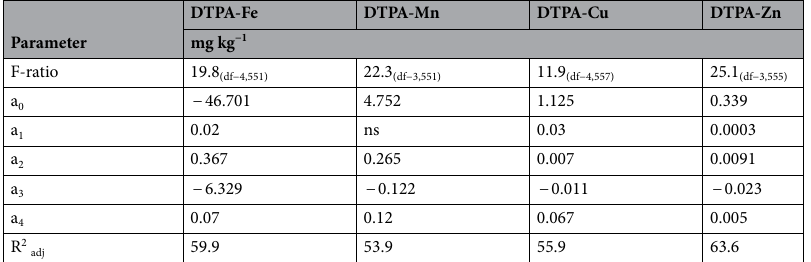
Table 5. Parameters of multiple regression of DTPA extractable micronutrient contents—Fe (Y1), Mn (Y2), Cu (Y3) and Zn (Y4) of elevation and soil variate of NE soils: clay, pH, SOC (Y1 = a0 + a1 × elevation + a2 × clay + a3 × pH + a4 x SOC); (Y2 = a0 + a2 × clay + a3 × pH + a4 × SOC); (Y3 and Y4 = a0 + a1 × elevation + a2 × clay + a3 × pH + a4 × SOC). The effect of climate variables (rainfall,